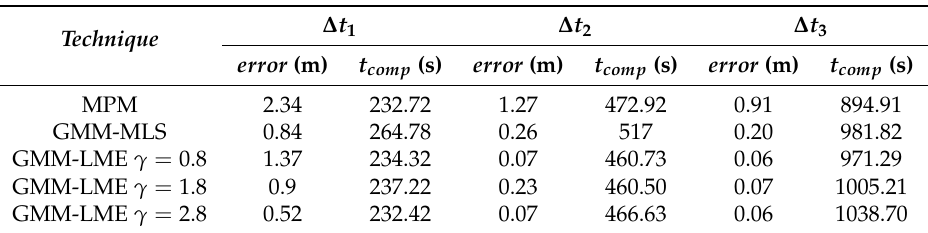
Table 1. Rolling disk. Absolute errors and computational